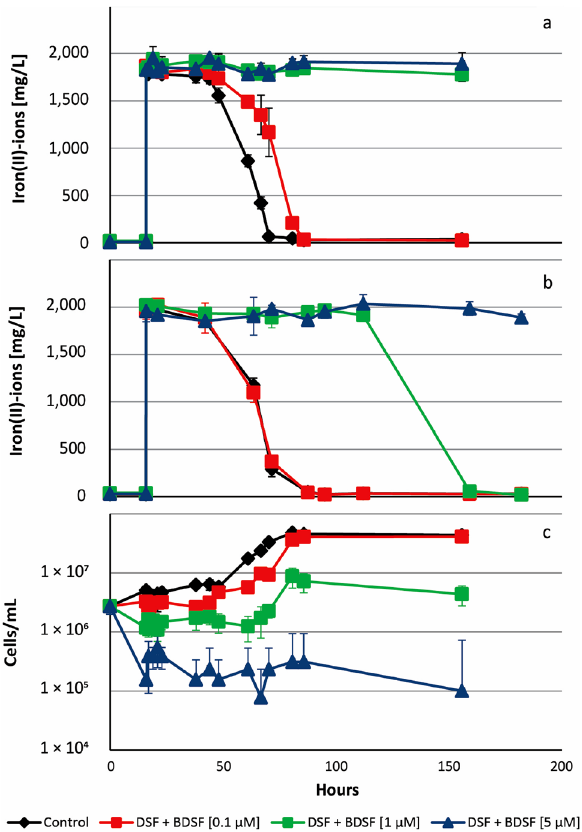
Figure 6. Iron-grown cells of L. ferriphilum T are more sensitive to inhibition by DSF molecules than pyrite grown cells. Cultures were inoculated with 4 × 10 6 cells/mL cells of L. ferriphilum T and exposed to 0.1, 1, and 5 µM DSF ((Z)-11-methyl-2-dodecenoic acid) and BDSF ((Z)-2-dodecenoic acid) for 16 h before 32 mM iron(II)-ions were added. Iron(II)-grown ( a ) and pyrite-grown cells ( b ) were differentially inhibited in iron(II) oxidation. Growth in presence of increasing concentrations DSF/BDSF is strongly effected as shown for iron(II)- grown cells ( c